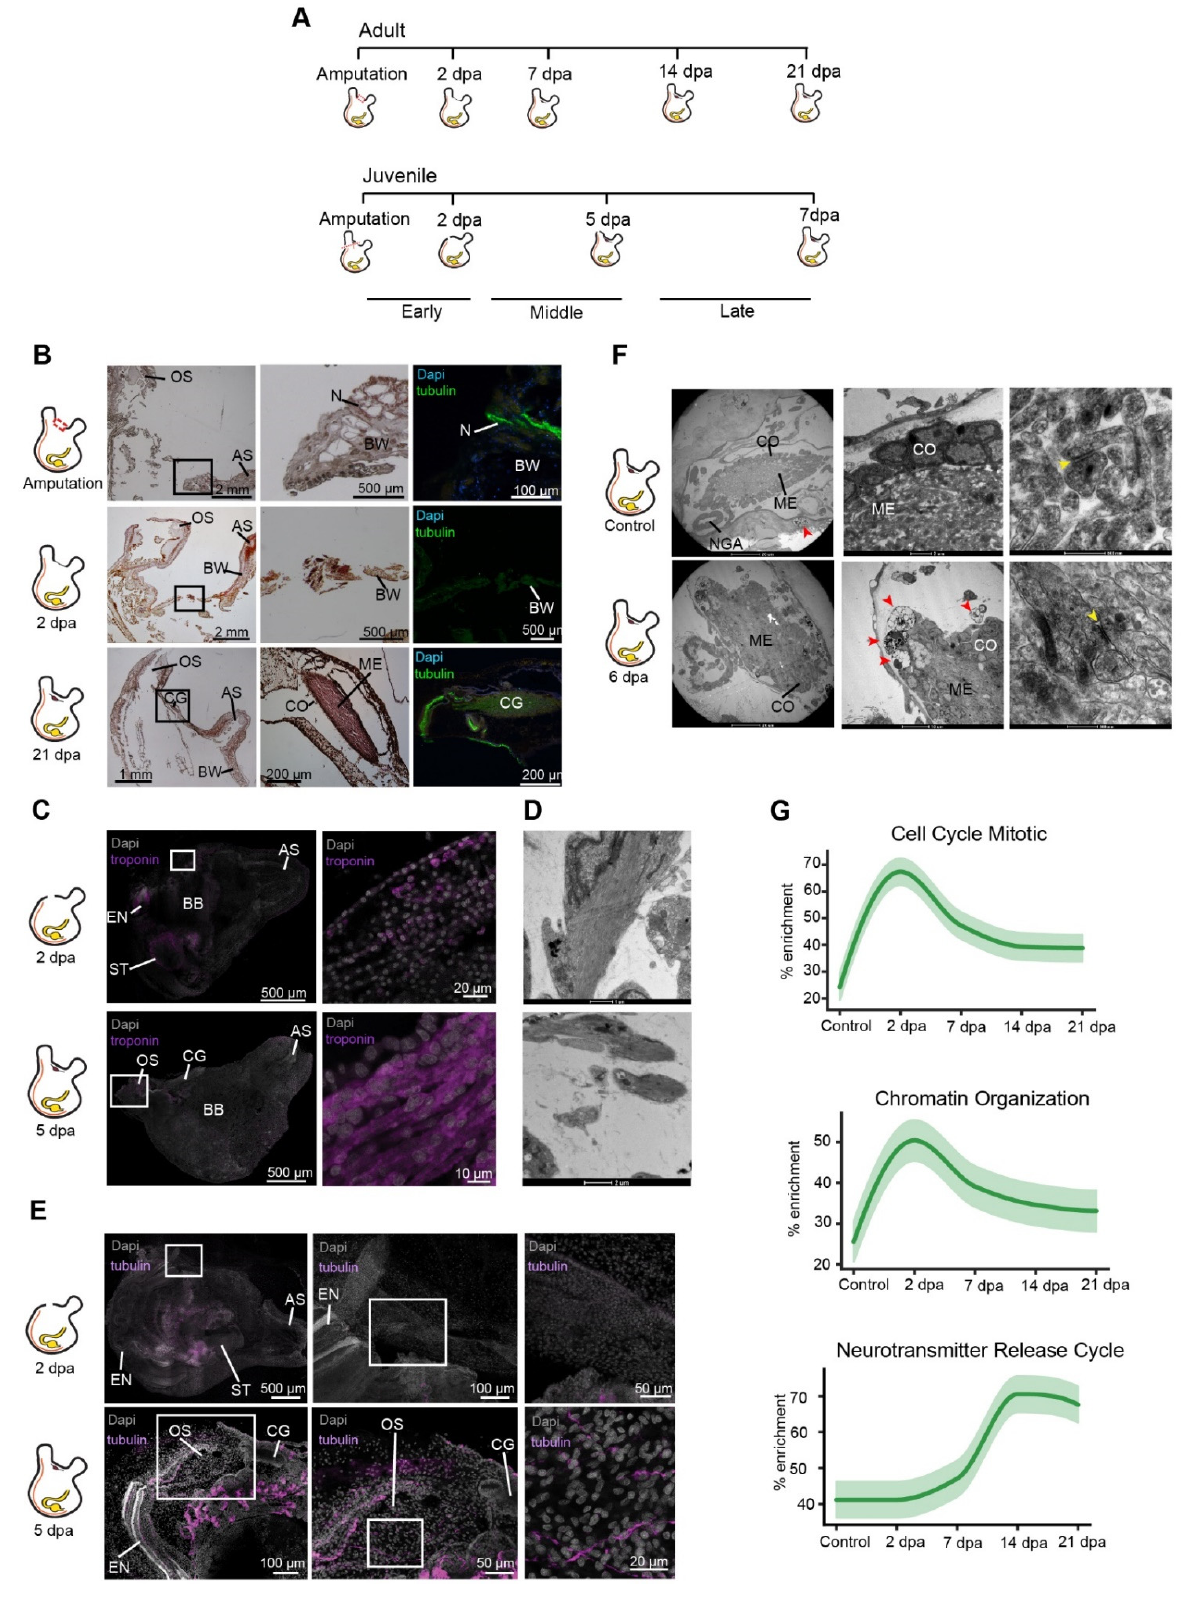
Figure 2. Three distinct anatomical and functional stages characterize CNS regeneration. ( A ) Regen- eration timeline showing the difference in regeneration rate between adults and juveniles along the